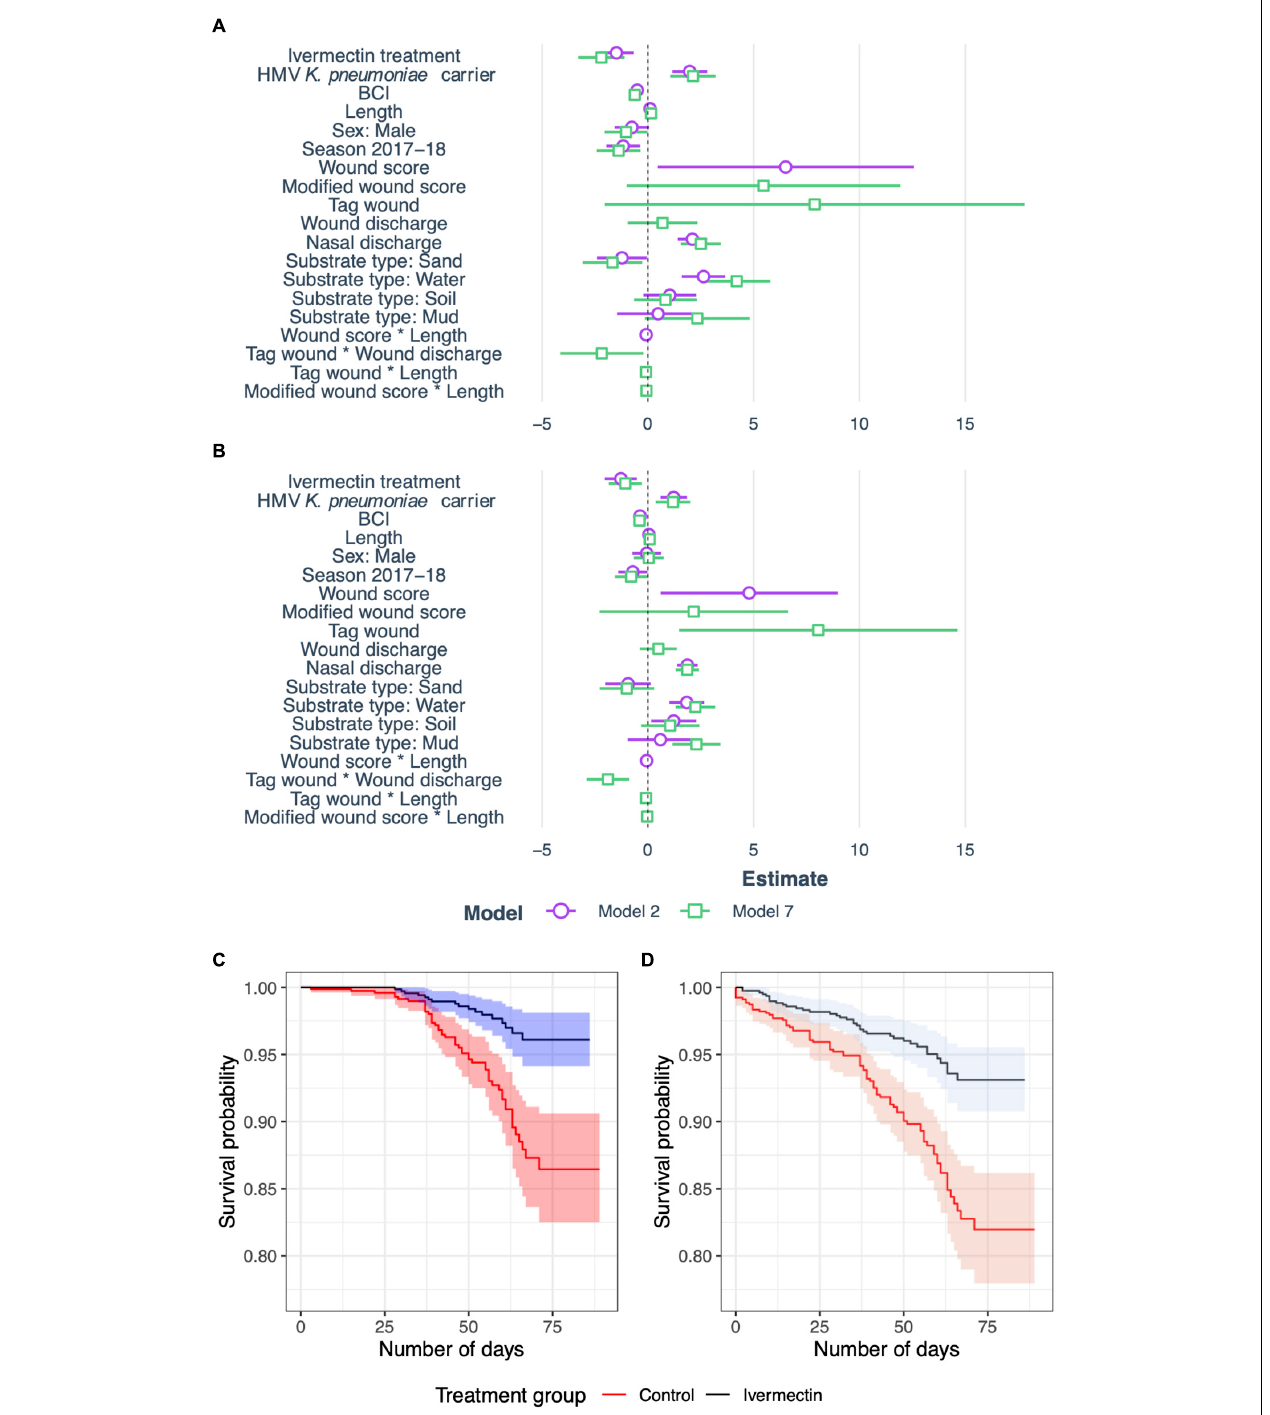
FIGURE 3 | Summary plots of risk factors for mortality in New Zealand sea lion ( Phocarctos hookeri ) pups at Sandy Bay, Enderby Island. (A) Coefficients from the best generalized linear model selected by AIC for pup mortality due to hypervirulent Klebsiella pneumoniae (Model 2) and adjusted model to investigate wound score uncertainty (Model 7). 95% confidence intervals are shown. (B) Coefficients from the Cox proportional hazards model for pup mortality due to hypervirulent K. pneumoniae , clustered by individual pup for Model 2 and Model 7. 95% confidence intervals are shown. (C) Proportion of surviving New Zealand sea lion pups in ivermectin treatment and control groups with shaded 95% confidence intervals. Outcome has been censored to include only mortality due to hypervirulent K. pneumoniae . (D) Proportion of surviving New Zealand sea lion pups in ivermectin treatment and control groups with shaded 95% confidence intervals. Outcome includes all causes of